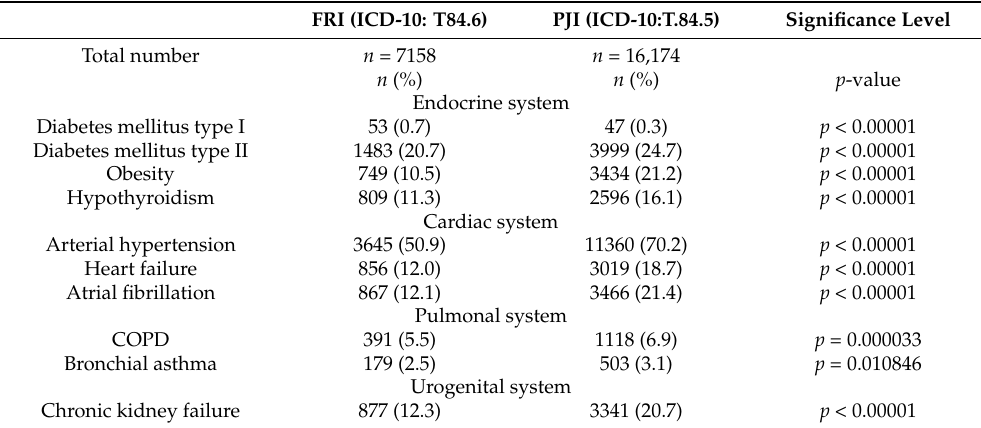
Table 1. Absolute number and proportion of comorbidities of fracture-related infections and peripros- thetic joint infections with statistical difference between FRI and